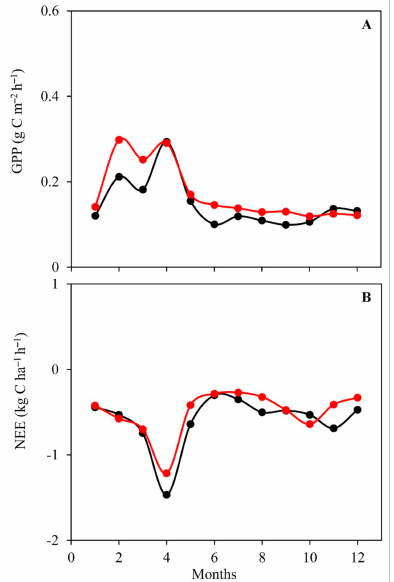
Figure 9. Simulations with calibration (solid red lines) for the wet season (simulation M) and dry season (simulation G) and eddy covariance observations (solid black lines) of monthly mean values of CO 2 fluxes of 2015. Gross primary production (GPP; ( A )) and net ecosystem CO 2 exchange (NEE; ( B )). For details on the calibrated parameters of simulations M and G, see Table 2. Regarding NEE, carbon uptake was denoted as negative values and carbon release was denoted as positive values. For GPP, carbon uptake was denoted as positive